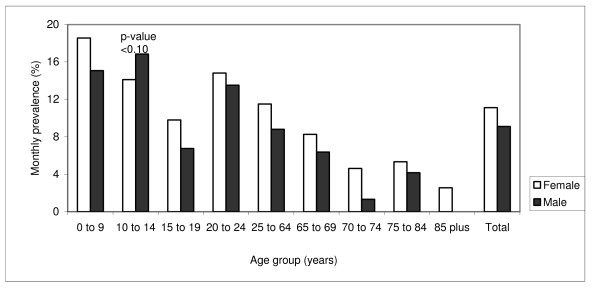
Monthly prevalence of acute gastrointestinal illness by age group and gender, in the province of British Columbia, Canada, showing p-values < 0.10, indicating association between prevalence and gender, per age group.